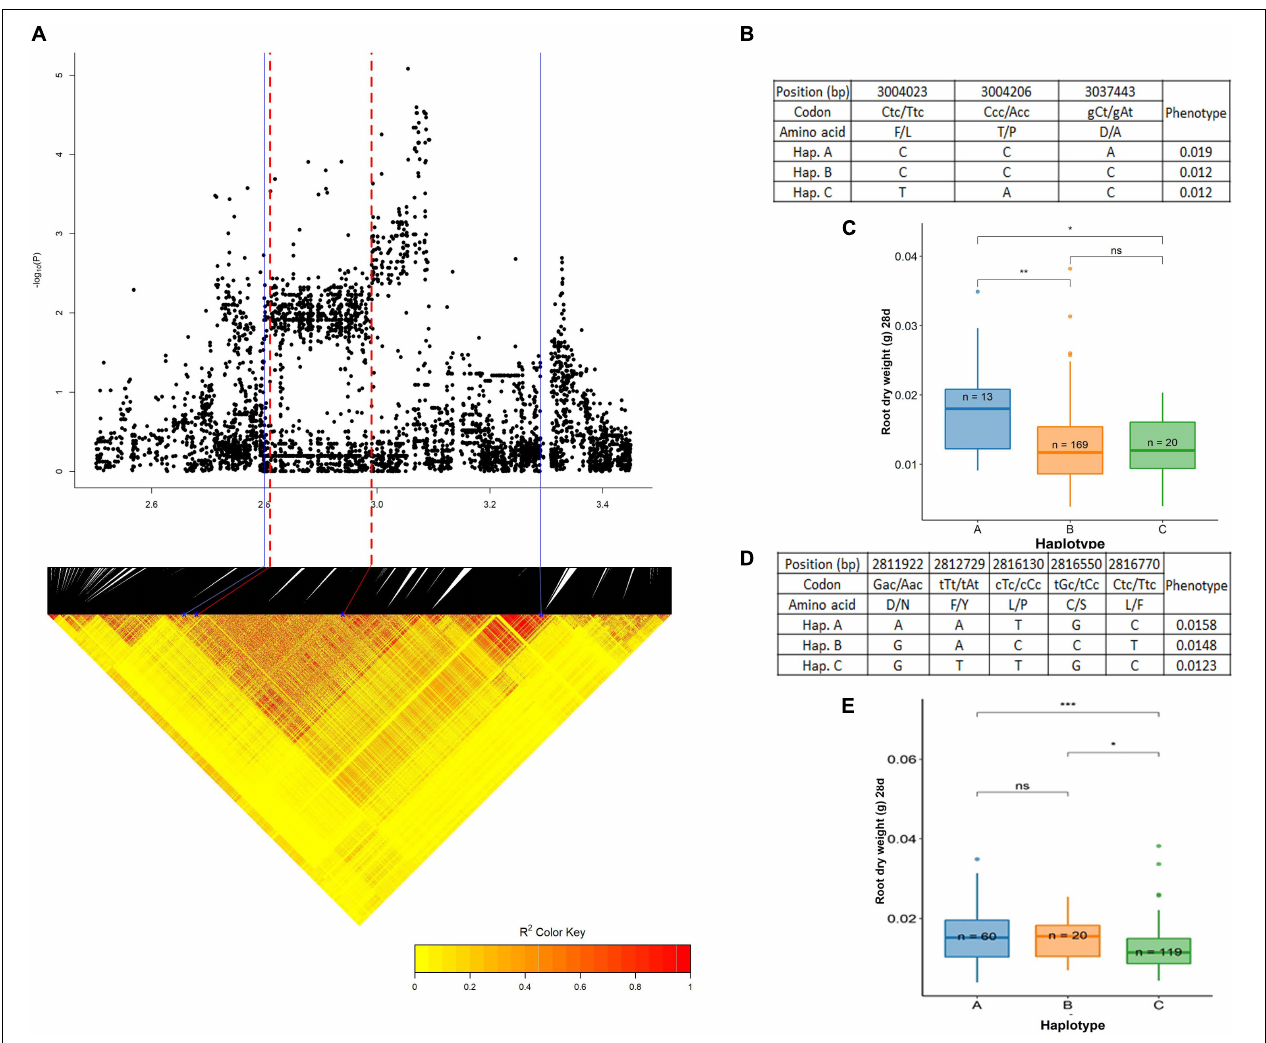
FIGURE 8 | Significant association for root dry weight at 28 days on chromosome 3- 3.05 Mb. (A) Local Manhattan plot (top) and LD heat map (bottom) of QTL on chromosome 3, the blue solid line represents the candidate regions and red dash line represents the candidate genes LOC_Os03g05640 ( OsPht 1:2 ) and LOC_Os03g06000 ( OsEXPA12 ); (B) the synonymous and non-synonymous SNPs in the candidate gene OsPht 1:2 significantly associated with root dry weight, and amino acid variations; (C) variation in root dry weight at 28 days indicated haplotypes of OsPht 1:2 ; (D) the synonymous and non-synonymous SNPs in the candidate gene OsEXPA12 significantly associated with root dry weight, and amino acid variations; and (E) variation in root dry weight at 28 days indicated haplotypes of OsEXPA12. Significance level; * p < 0.05, ** p < 0.01, *** p < 0.001, **** p < 0.0001. ns, non